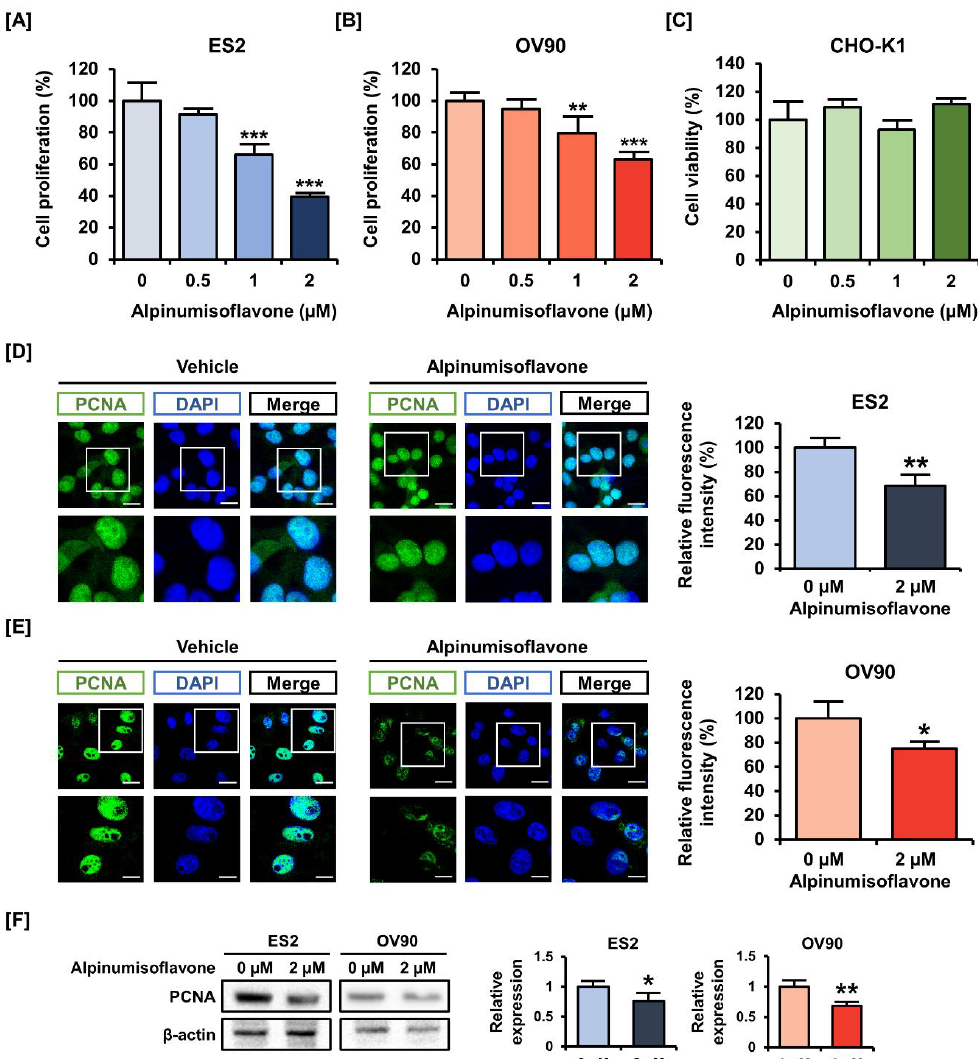
Figure 1. Effects of alpinumisoflavone on the proliferation of human ovarian cancer cells. ( A , B ) Cell proliferation assay was adopted to detect the proliferation of ES2 and OV90 cells in response to alpinumisoflavone (0, 0.5, 1 and 2 μM) for 48 h. The results were compared to cells that had been treated with a vehicle. ( C ) Cell viability of CHO-K1, normal ovarian cells, was analyzed. ( D , E ) PCNA proteins are depicted by green fluorescence, while DAPI counterstaining for nuclei is represented by blue fluorescence. Cells were treated with alpinumisoflavone for 48 h. Metamorph software was employed to measure the relative intensity of the green fluorescence compared to vehicle-treated cells. The scale bar displayed 20 μm (the first horizontal line) and 40 μm (the second horizontal line). ( F ) Immunoblots of PCNA in response to alpinumisoflavone (2 μM ) treatment in ES2 and OV90 cells. All experiments were performed in triplicate. According to the adopted standards, the level of significance between the vehicle and treatment groups is depicted by asterisks (* p < 0.05, ** p < 0.01 and *** p < 0.001).